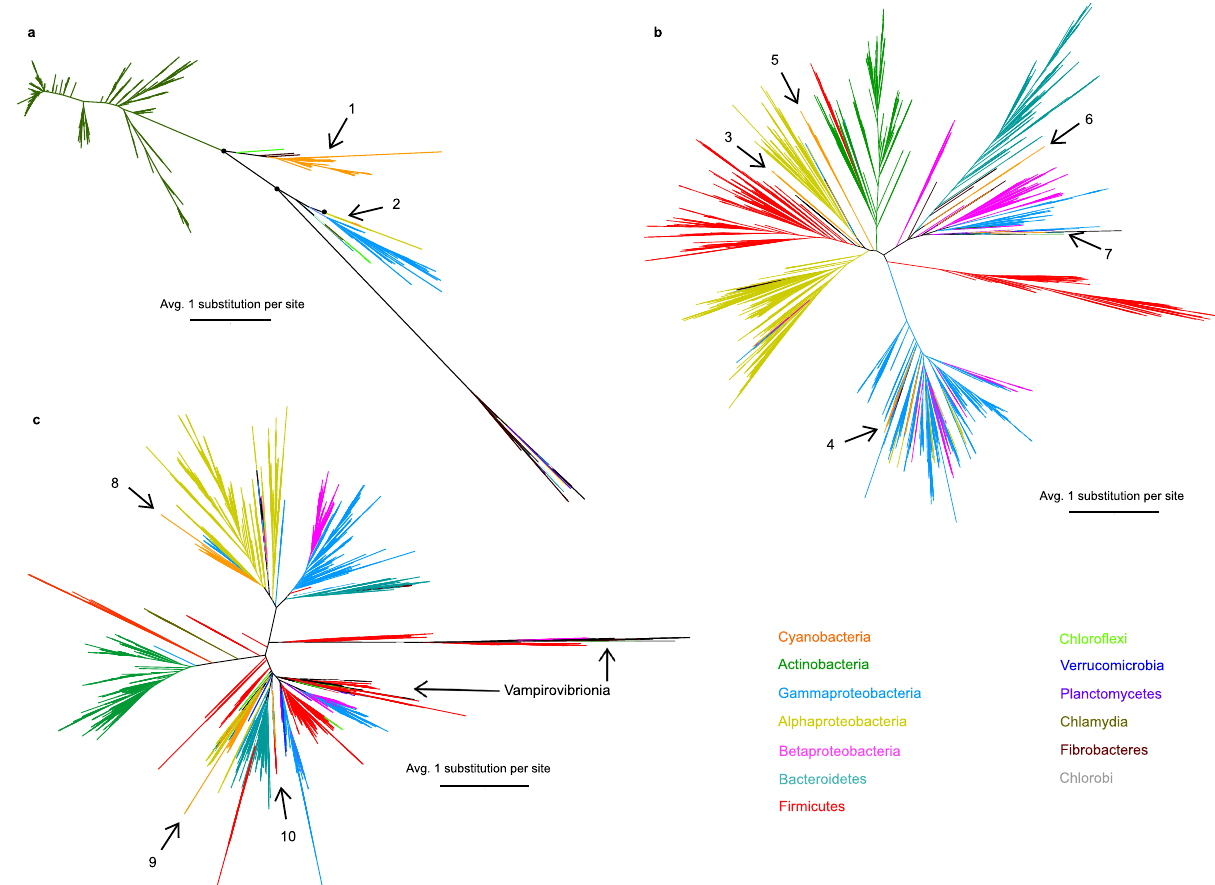
Fig. 1 Evolutionary relationships of superoxide dismutases in bacteria. a NiSOD b CuZnSOD c Fe- and Mn-utilizing SODs. a and b are representative of three independent replicates (Supplementary Figs. 11 – 12), whereas c is the most likely of three potential topologies (Supplementary Fig. 1). All trees were constructed with ML methodology implemented in IQ-TREE v1.6.1 46 . Branches are colored to represent proteins found in 1 of 13 bacterial phyla: Cyanobacteria (orange), actinobacteria (green), gammaproteobacteria (blue), alphaproteobacteria (yellow), betaproteobacteria (pink), bacteroidetes (cyan), fi rmicutes (red), chloro fl exi (light green), verrucomicrrobia (dark blue), planctomycetes (purple), chlamydia (olive), fi brobacteres (dark green), and chlorobi (gray). Branch lengths represent the number of amino-acid substitutions per site with scale bars representing an average of one substitution per site. Numbered arrows indicate cyanobacterial proteins. Interesting UFBoot values ≥ 95 in all NiSOD replicate trees are indicated with black circles.